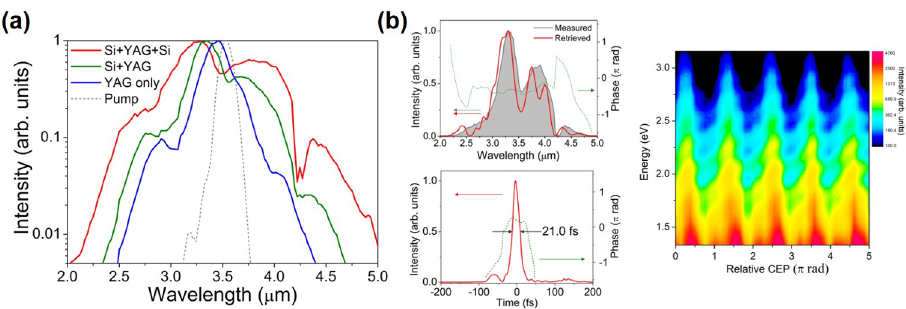
Fig. 2. (a): Results of spectral broadening with several combinations of YAG and Si plates. The black dashed curve shows the spectrum of the input MIR pulses. (b): Spectral and temporal profiles retrieved from an SHG-FROG result after the multiple-plate compressor